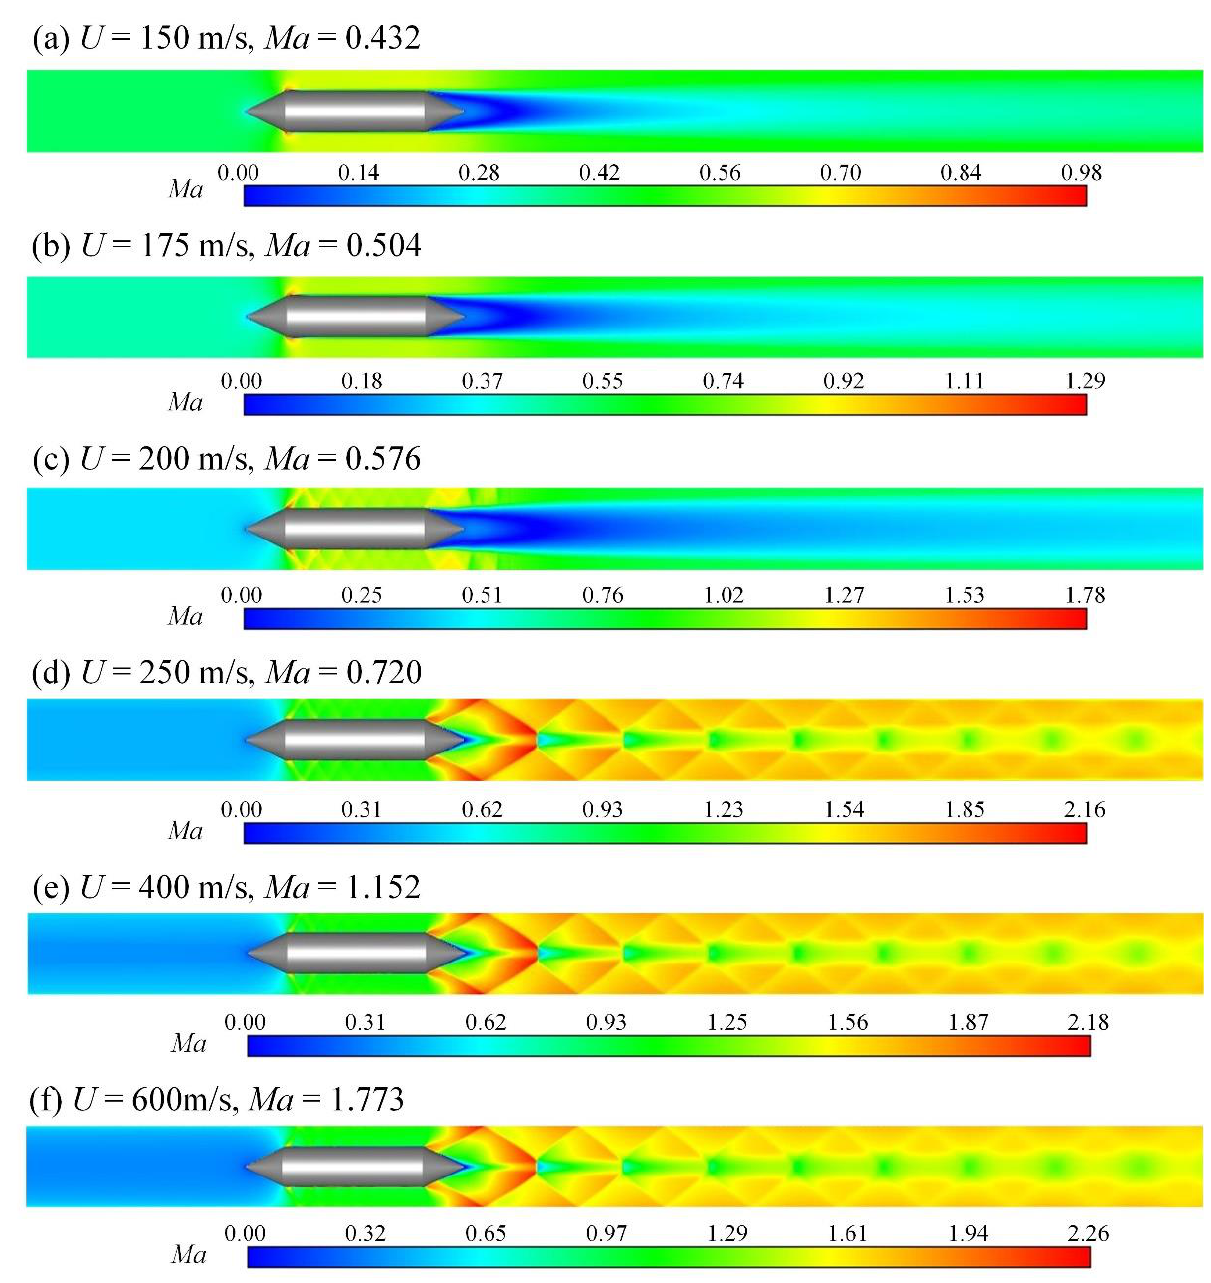
Figure 12. Mach number contours in the ( x, z ) plane at y = 0. In all, the drag of the tube train varying with the travelling speed demonstrates different variation tendencies in different speed cases from the subsonic to supersonic speeds. Hence, the relationship between the drag and travelling speed of tube trains can be divided into several range of speed to be elucidated. For this reason, the concept of designing the ETT system with different travelling speeds should be